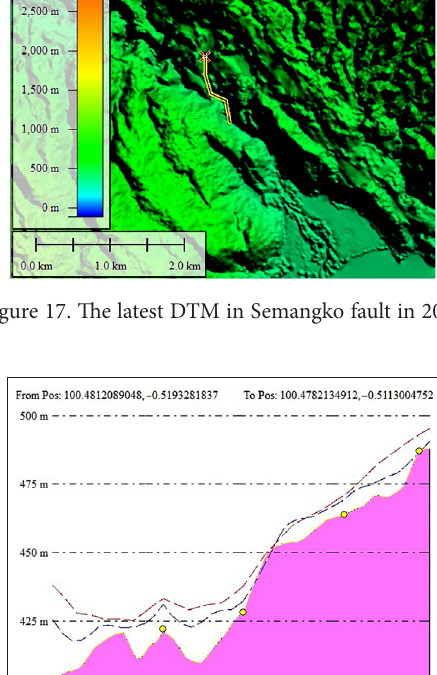
Table 1. comparison height difference between the latest DTM and field measurements